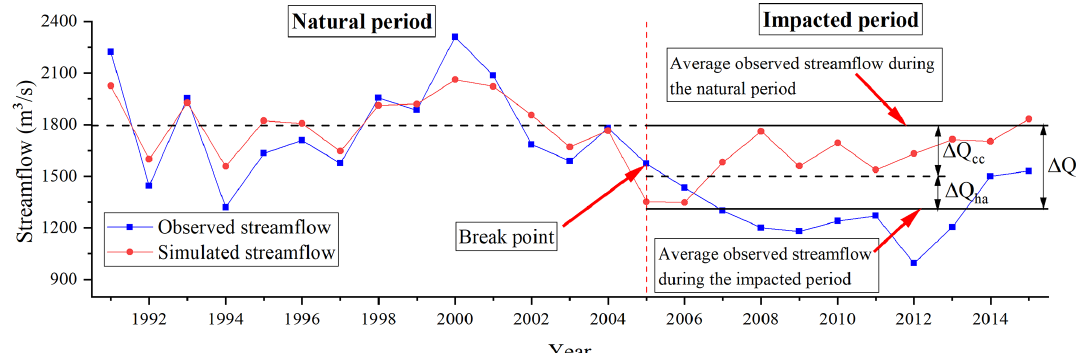
Figure 3. Schematic diagram of the contribution rate (CR) of climate change (CC) and human activities (HAs) to streamflow change using SWAT modeling. (Notation: (cid:49)Q , (cid:49)Q cc , and (cid:49)Q ha , respectively, represent the amount of streamflow change in the impacted period, the amount of streamflow change caused by CC, and the amount of streamflow change caused by human activities.) Table 2. Twenty-two selected SWAT model parameters in the sensitivity analysis at Yunjinghong station. Parameter Description Parameter range R_CN2 SCS runoff curve number for soil condition −